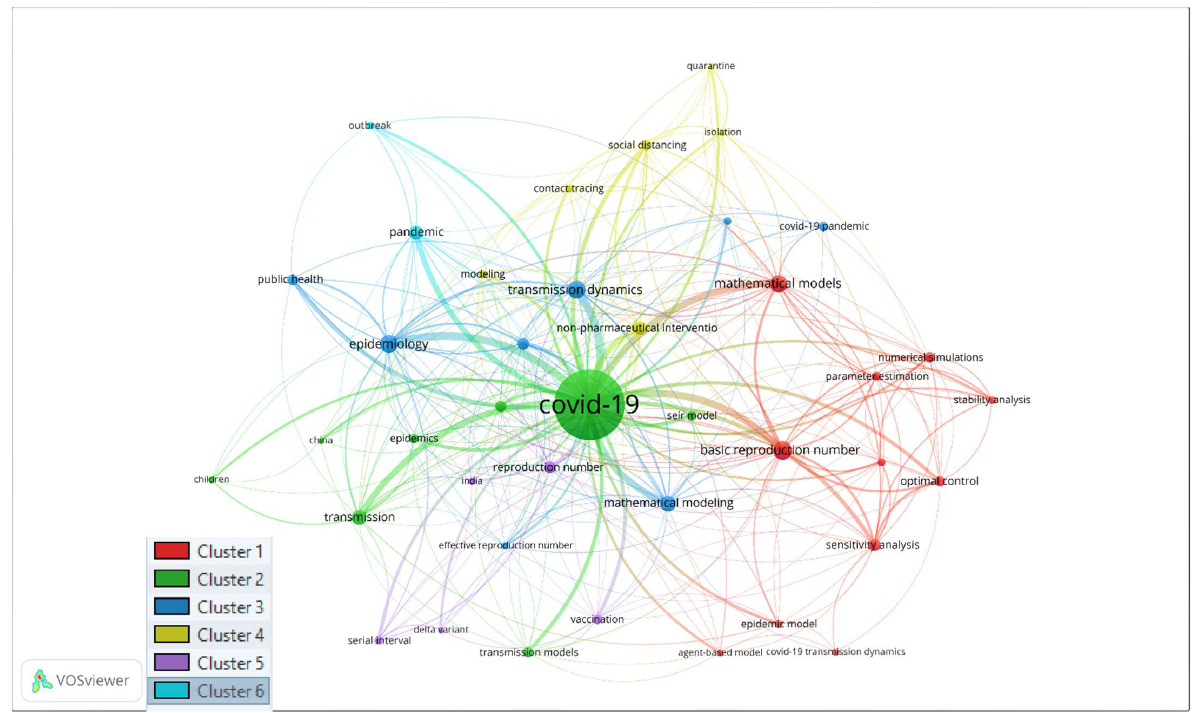
Figure 4. Keyword Co-occurrence.